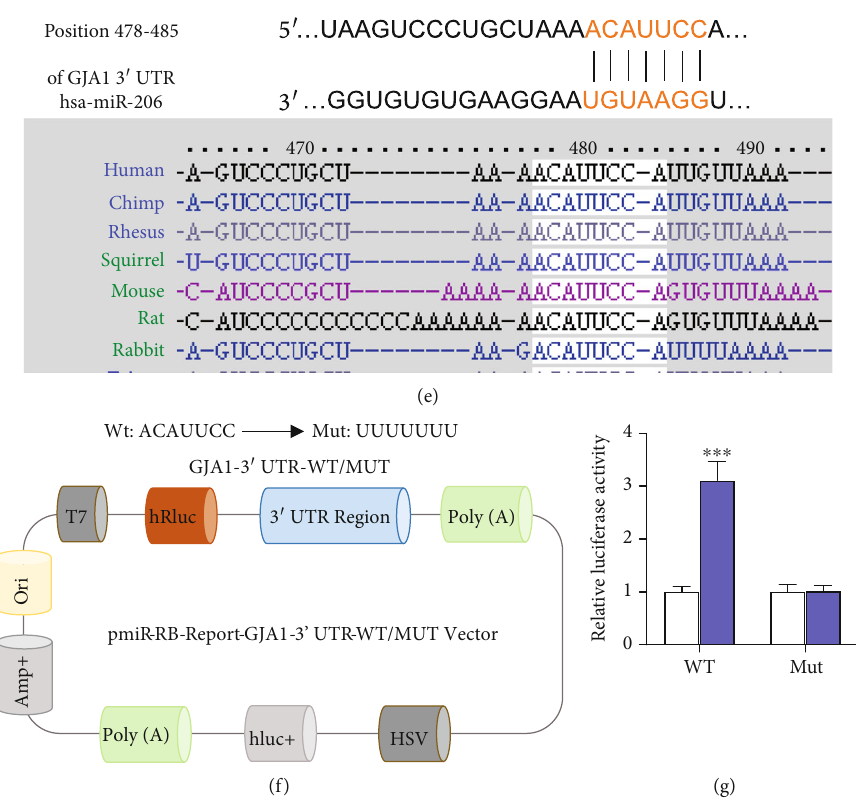
Figure 2: miR-206 directly targets GJA1. (a) The downstream targets of miR-206 were predicted at the miRDB database, and the top ten were selected as candidates. (b) PCR analysis of the expression of the above ten candidate targets in EPCs after downregulating miR-206. (c, d) Western blotting analysis of the protein levels of ten candidate targets in EPCs after knocking down miR-206. (e) The TargetScan database revealed the binding site of miR-206 on GJA1 3 ′ UTR. (f, g) Luciferase reporter assay of the luciferase activities of pmiR-RB- REPORT-GJA1-3 ′ UTR-Wt/Mut vectors in EPCs after miR-206 downregulation. ∗∗∗ p < 0 : 001